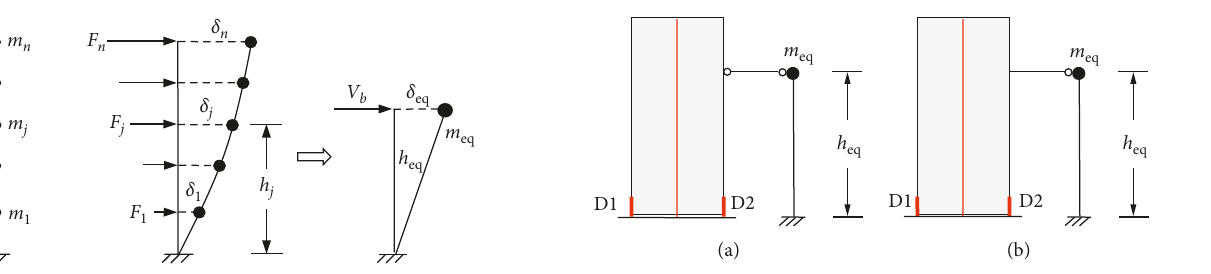
Figure 4: Simplified analysis model of the FSCW structure. (a) Pin-jointed system. (b) Rigid-jointed